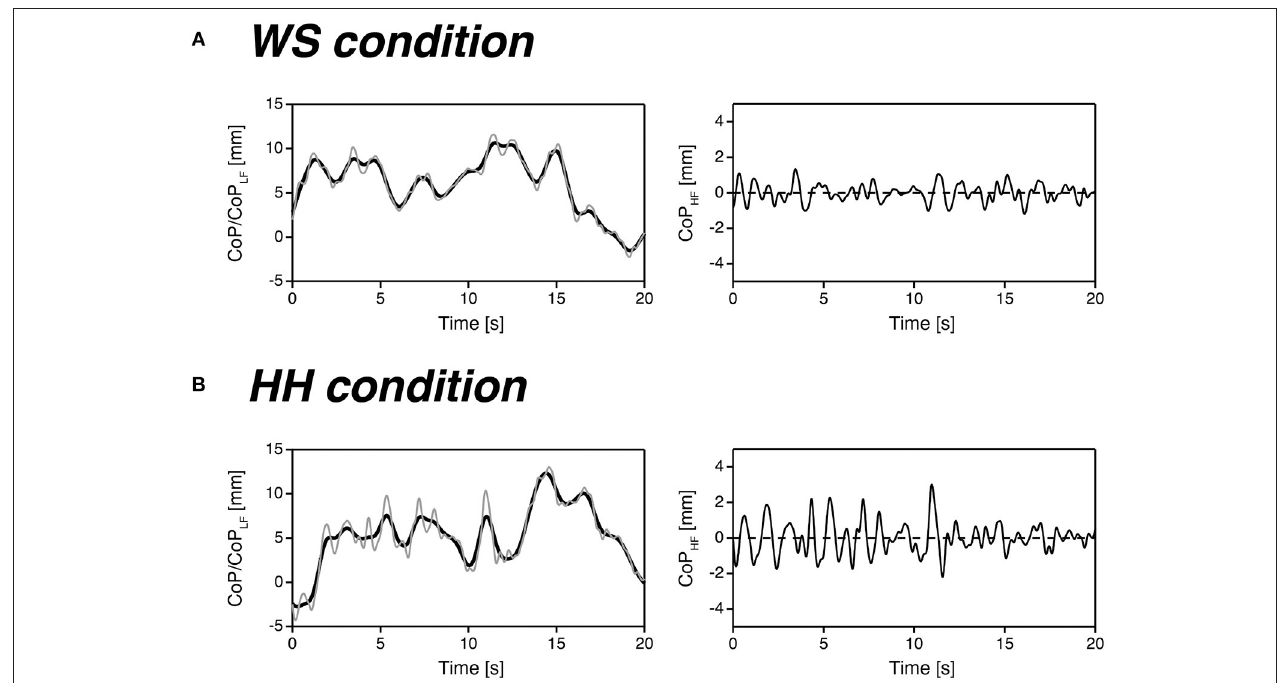
FIGURE 4 | Representative examples of the CoP ( thin gray line ) and CoP LF ( bold black line ) recordings ( left ) and corresponding CoP HF recordings ( right ) for one non-wearer in the WS (A) and HH (B)